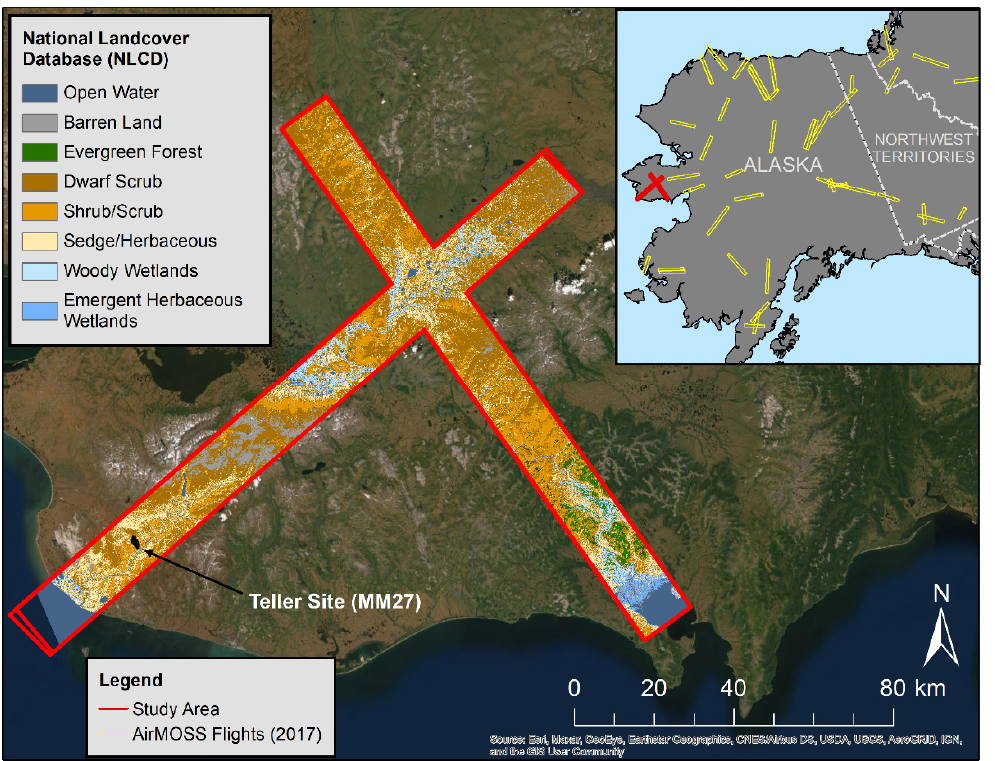
Figure 1. The main map illustrates the two footprints of the P-band SAR flight swaths over the Seward Peninsula (outlined in red). Shown within the flight footprints are dominant land cover types from the 2016 Alaska NLCD. The Teller Site, located at mile marker 27 of the Nome-Teller Highway, is highlighted in black. Inset shows all 2017 AirMOSS (P-Band) SAR footprints flown by the NASA ABoVE campaign over Alaska and Canada.